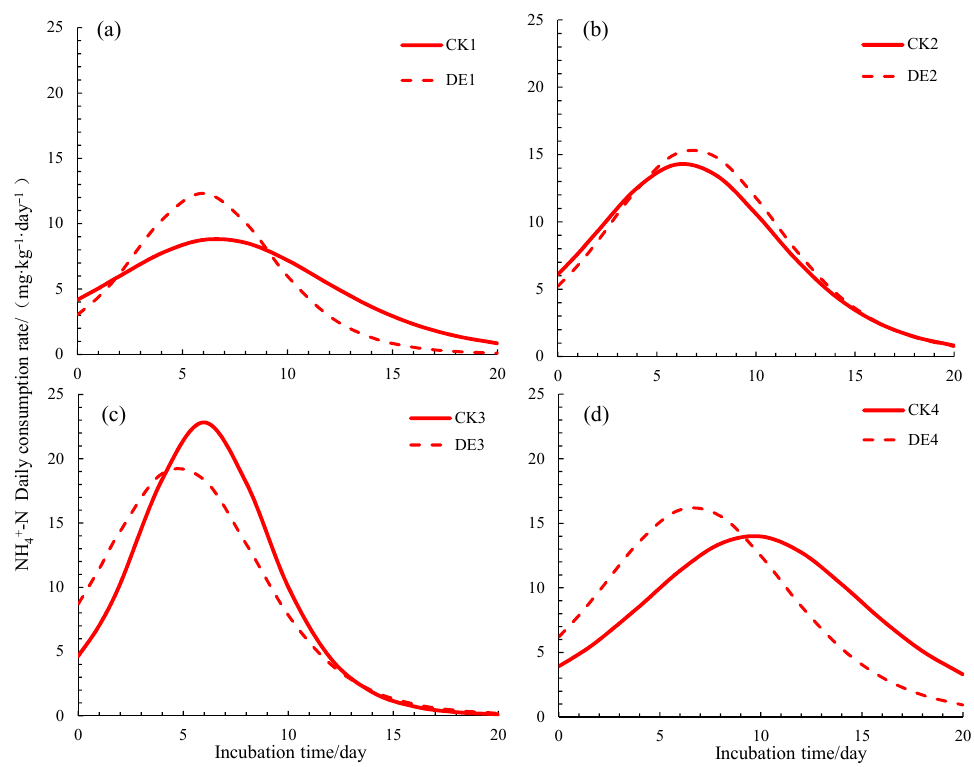
Figure 2. Daily consumption rate of soil NH 4+ -N under different treatments. Note: θ FC , soil field capacity; CK, ordinary water and DE, ionized water, ( a ) 30% θ FC, ( b ) 60% θ FC, ( c ) 100% θ FC, ( d ) 175% θ FC . Numbers in the treatment labels: 1, 30% θ FC ; 2, 60% θ FC ; 3, 100% θ FC and 4, 175% θ FC . With 30% θ FC , the DE1 treatment had a lower V 0 , and then, the NH 4+ -N consumption rate increased significantly, reaching V max (12.32 mg/(kg·day)) on day 6, which was 1.4